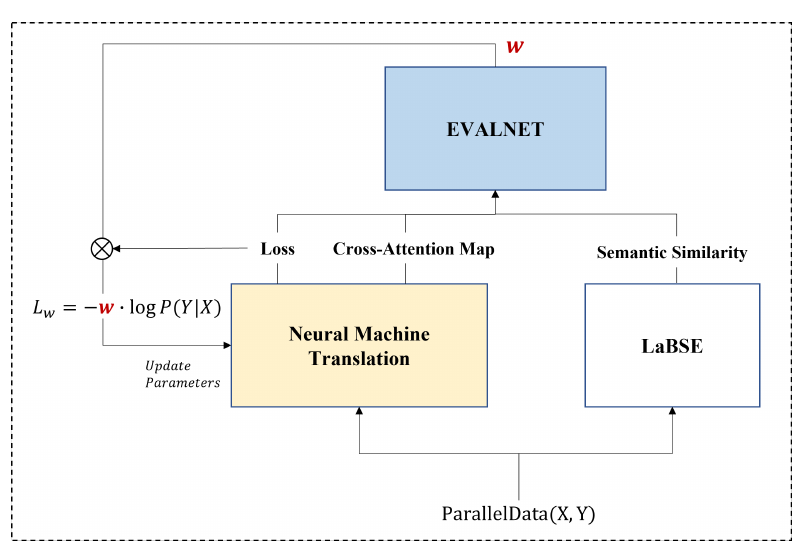
Figure 1. The overall training process of NMT using